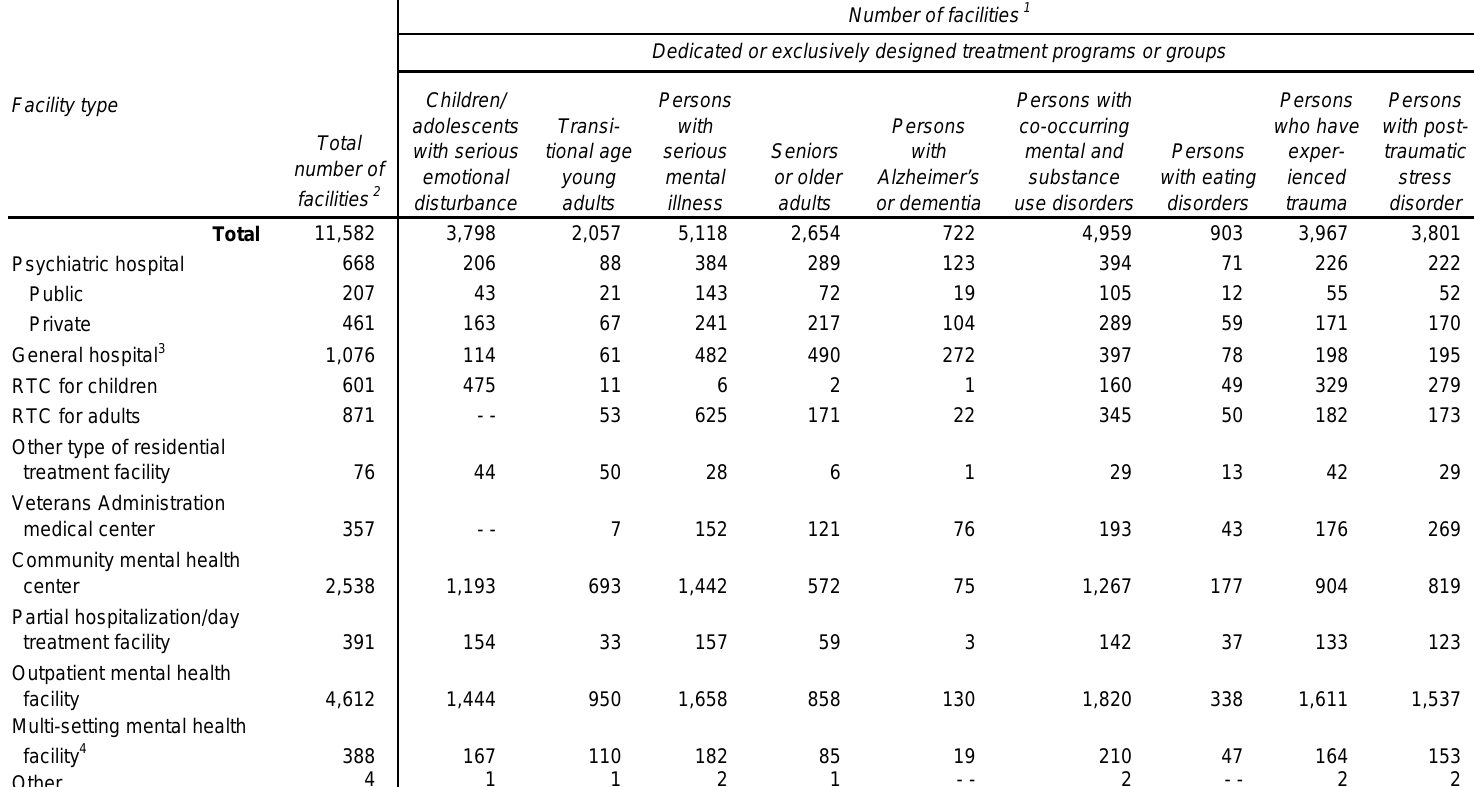
Table 2.6a. Mental health treatment facilities offering treatment programs or groups dedicated or exclusively designed for specific